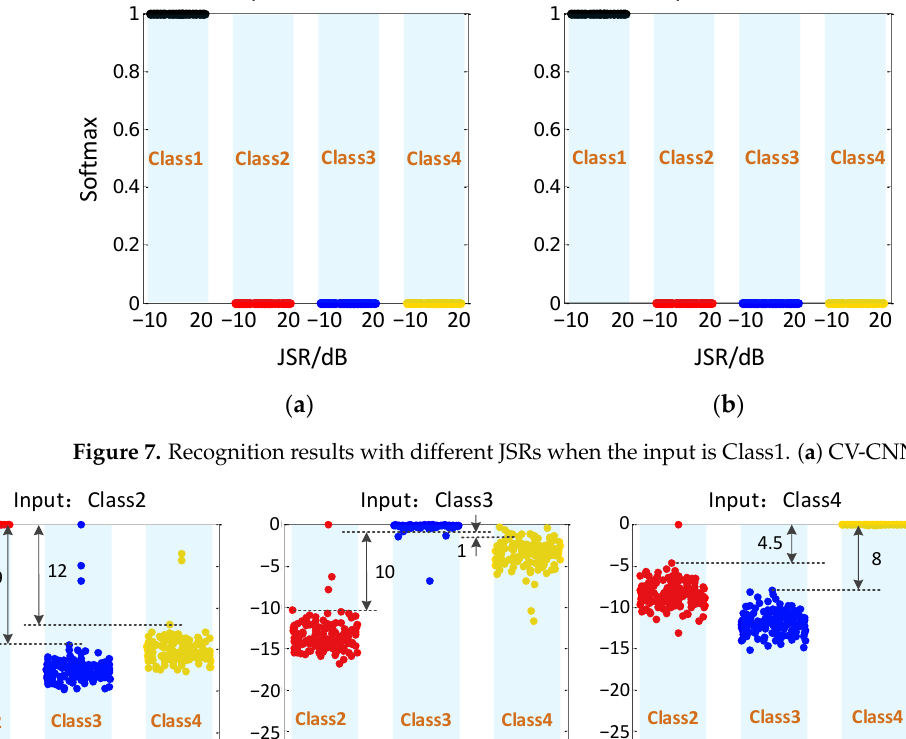
Figure 7. Recognition results with different JSRs when the input is Class1. ( a ) CV-CNN, ( b ) RV-